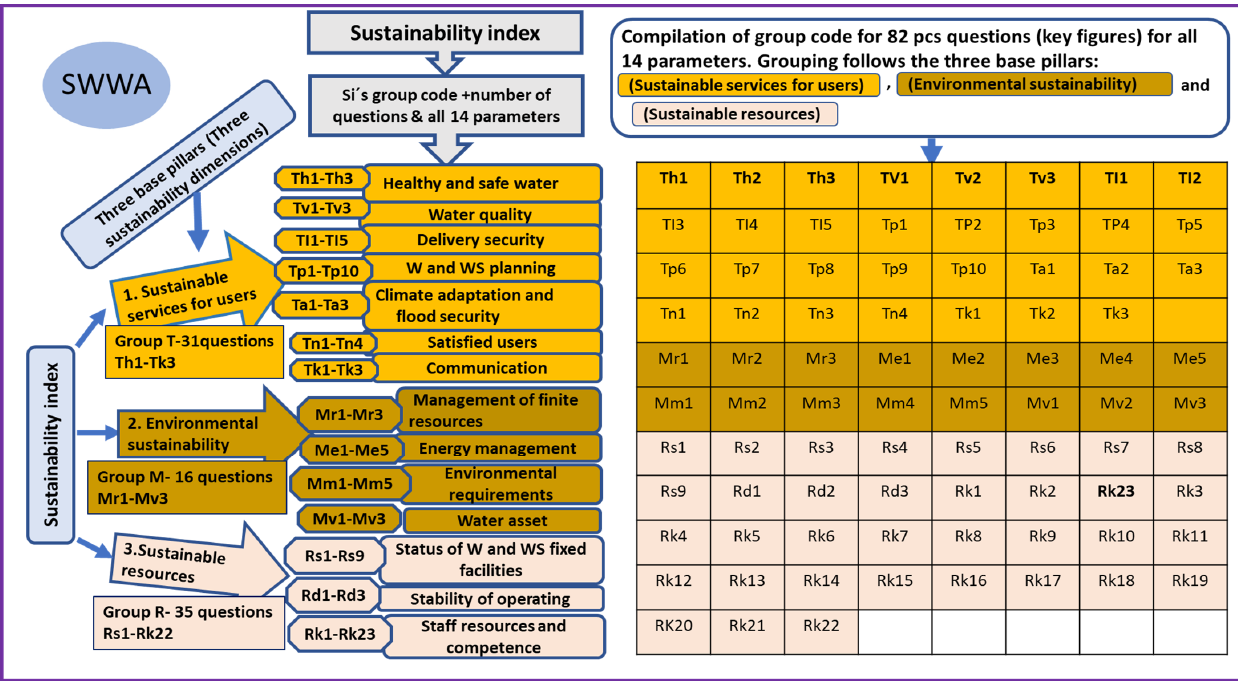
Figure 2. Three base pillars, fourteen parameters, and group code compilation for questions (key figures) of each base pillar and its parameters.